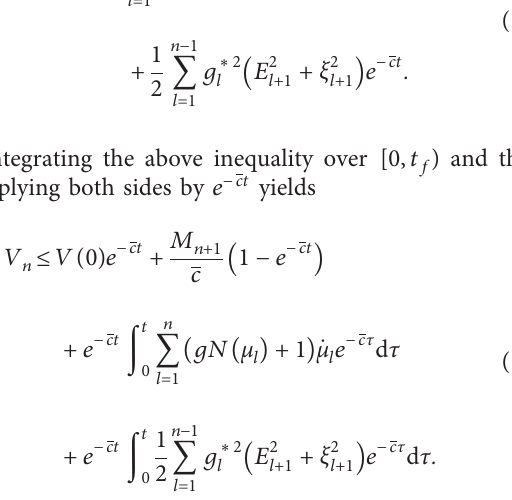
Figure 1: Trajectories of y and y